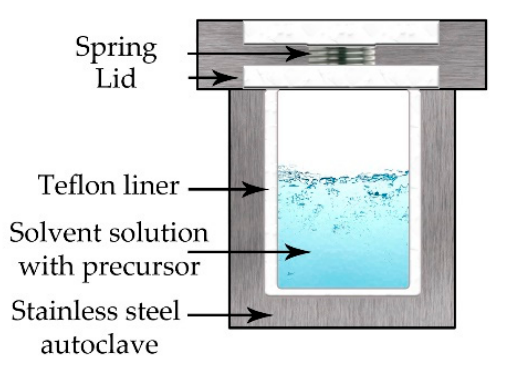
Figure 6. Teflon-lined stainless-steel autoclave used for hydrothermal and solvothermal reactions.